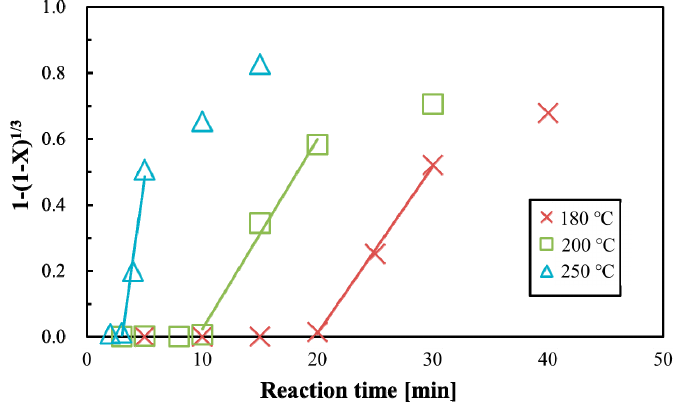
Figure 7. Analysis of water-soluble content (WSC) ratio of polylactic acid (PLA) in sub-critical water using the surface reaction and shrinking core model. Table 4. Kinetic constant and induction time of the water-soluble content (WSC) ratio of polylactic acid (PLA).